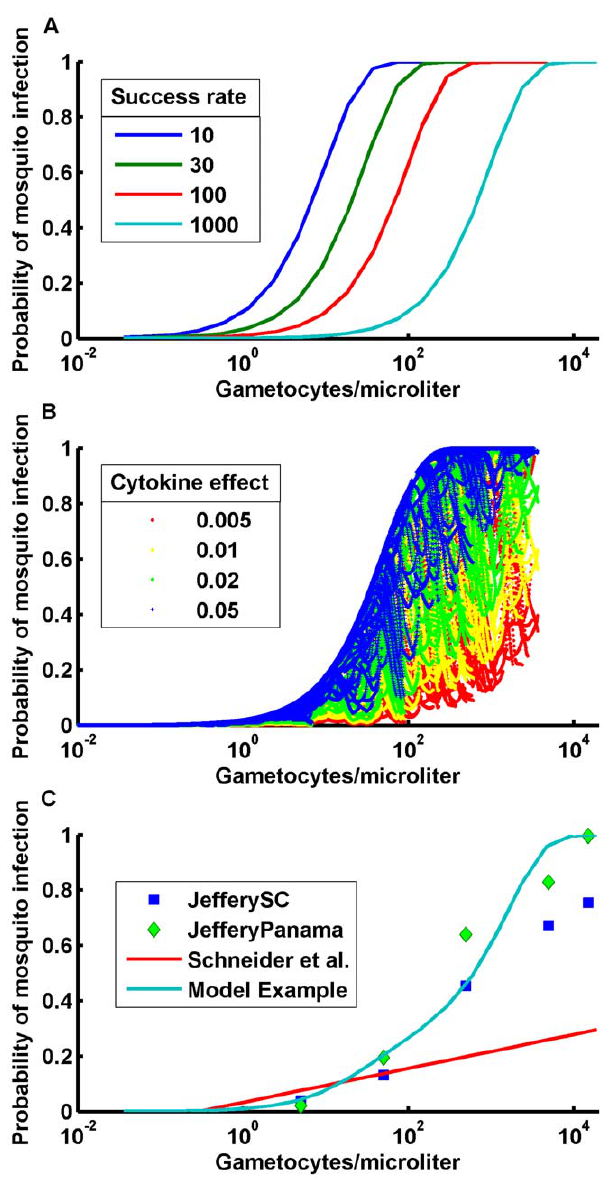
Figure 6. Infectivity to mosquitoes is governed by gametocyte density and other factors. The probability of mosquito infection versus gametocyte count for A) varying survival factors; B) varying effect of inflammatory immune response on gametocyte success. Inflamma- tory cytokine mediated gametocyte inactivation can explain widely varying mosquito infection rates even for a single individual; and C) data for the probability of mosquito infection with a model example survival factor of 100 and a cytokine effect of 0.94.